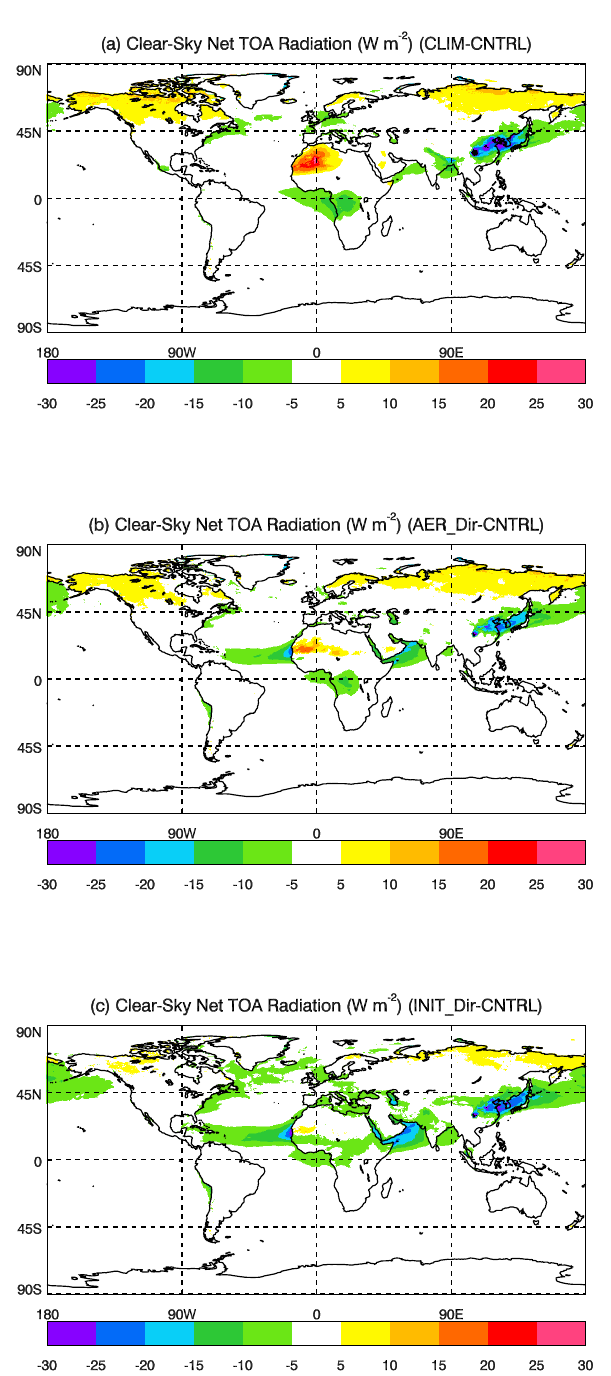
Fig. 8. Direct impact of aerosol on the clear-sky net radiation at TOA from (a) CLIM, (b) AER_DIR and (c) INIT_DIR at T + 120. AEROSOL can be from CLIM, AER_DIR or INIT_DIR sim- ulations. Note this is not a true aerosol radiative perturba- tion, as CNTRL still contains a basic aerosol representation.